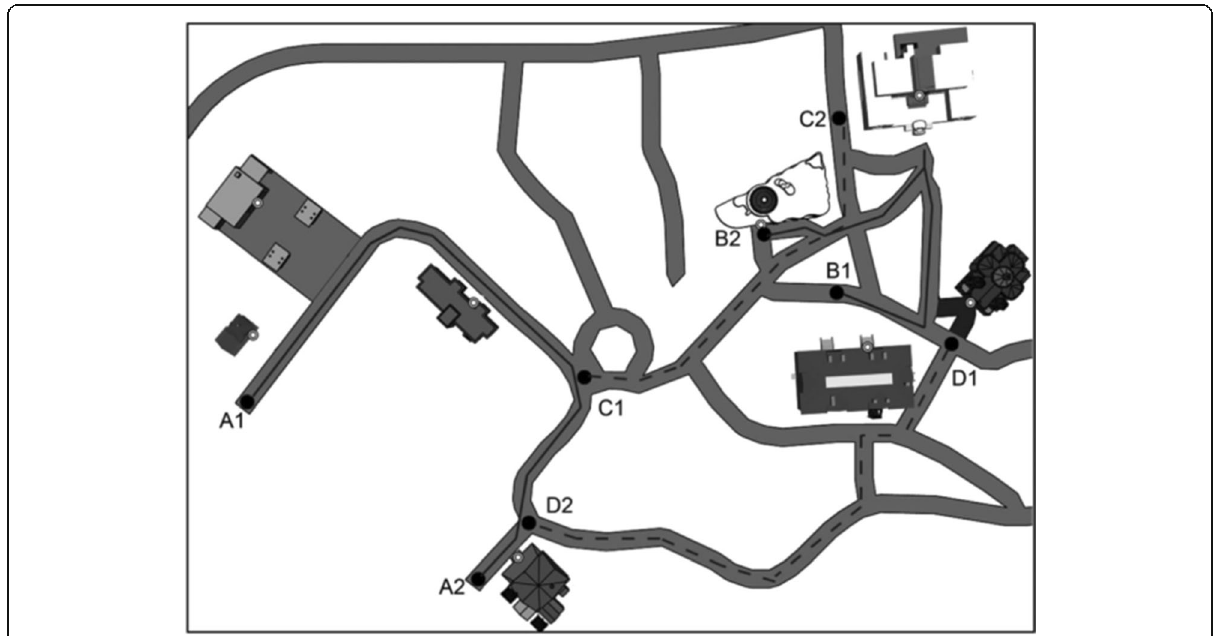
Fig. 2 Aerial view map of Virtual Silcton showing the two main routes (solid lines A and B), the two connecting routes (dashed lines C and D) and the layout of buildings on each route. The letter – number combinations are used to indicate the start and end points along each of the main and connecting routes (i.e., participants walked from point 1 to point 2 and then back to point 1 for each of the main and connecting routes, thus traversing each route twice). Participants had to learn the names and locations of four target buildings on each of the two main routes. The presentation of the main routes were counterbalanced (A first or B first) and the presentation of the connecting routes were counterbalanced (C first or D